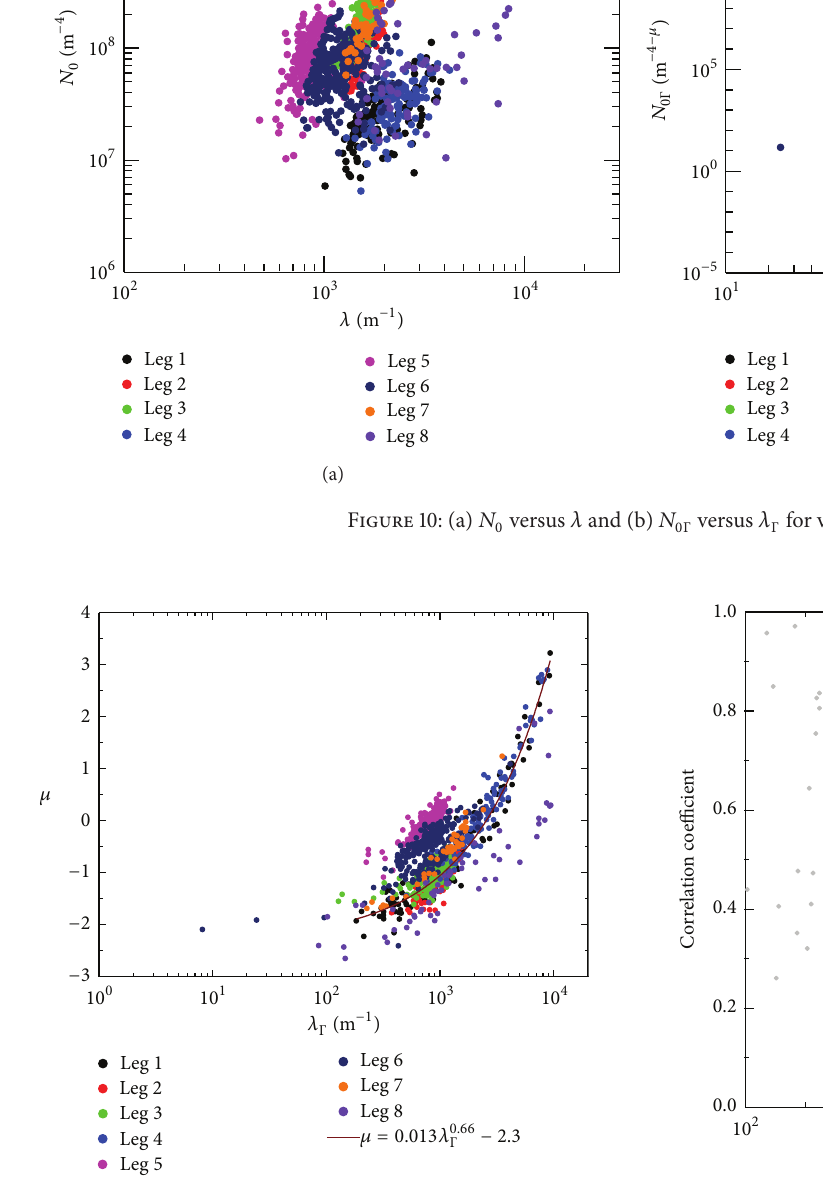
Figure 11: 𝜇 versus 𝜆 Γ for various legs.